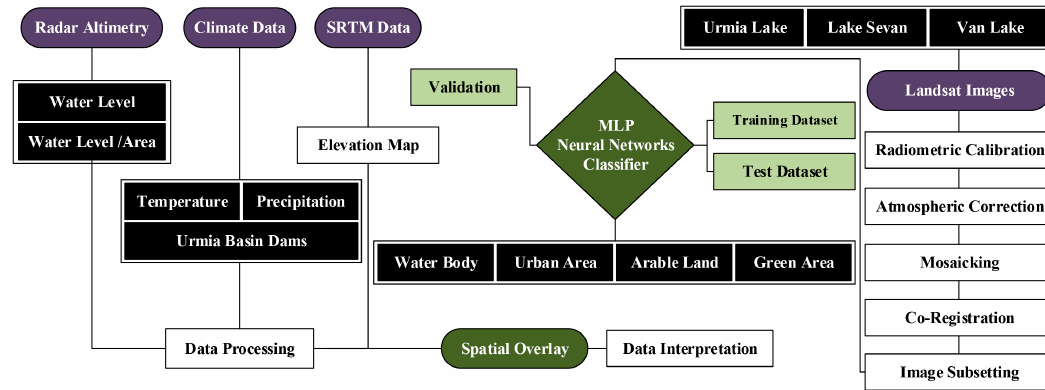
Figure 3. Schematic representation of the methodology.